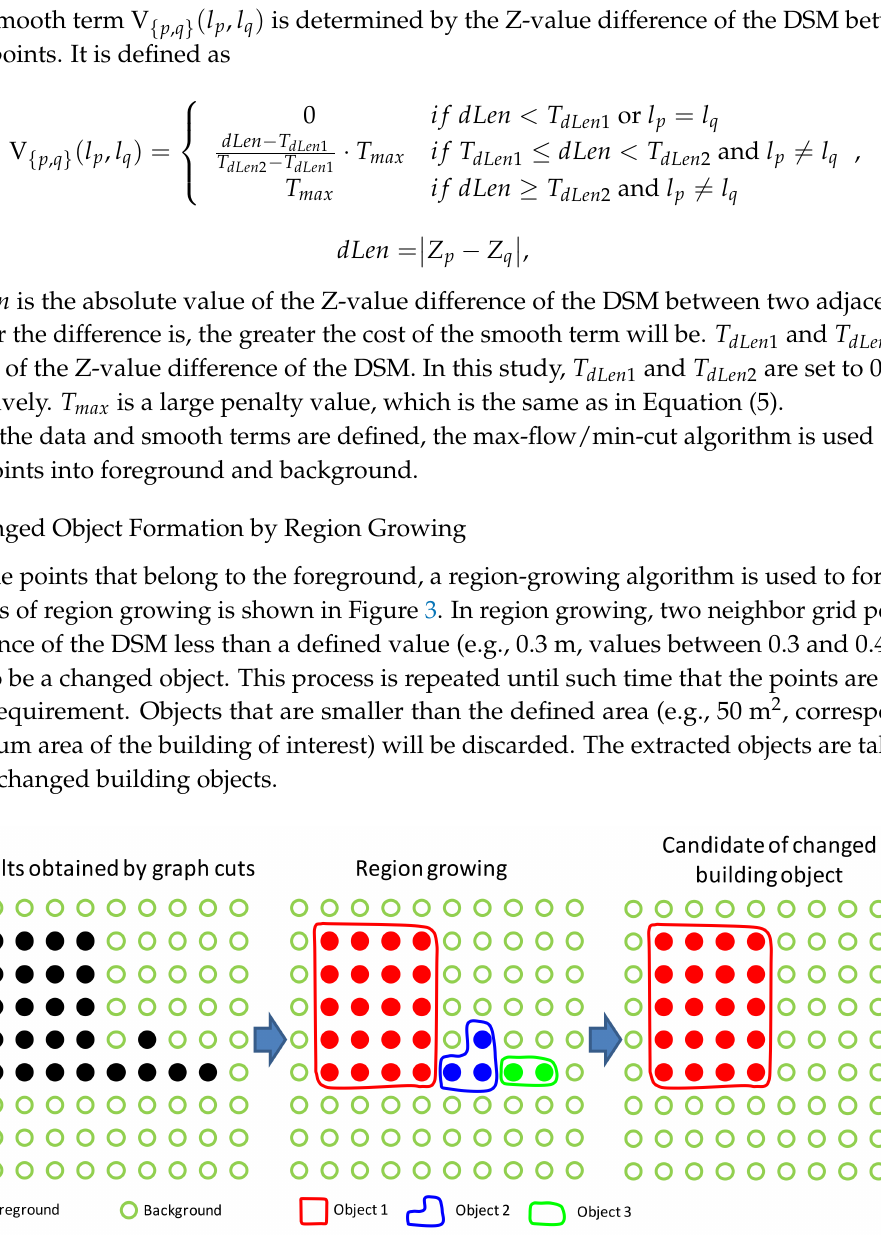
Figure 3. Changed object formation by region